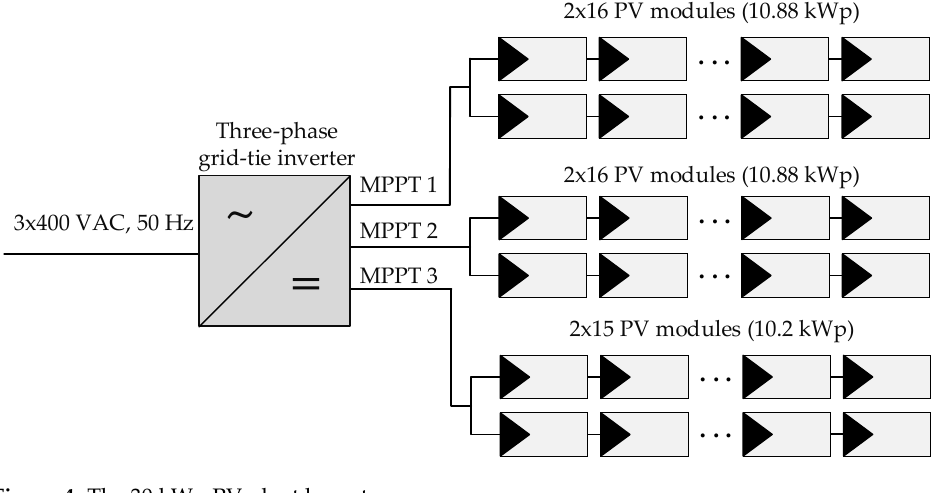
3x400 VAC, 50 Hz